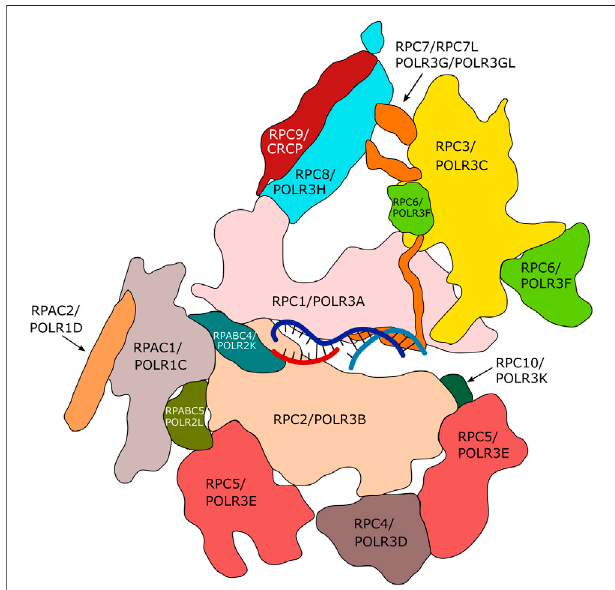
FIGURE 1 | Subunits of human RNA polymerase III. Fourteen of the seventeen subunits of human Pol III are appropriately assigned. Subunits POLR2E, POLR2F and POLR2H are not displayed. The Figure is inspired by the structure of human Pol III published by Girbig et al. (2021) (PDB7AE3). The RPC4/RPC5 hetero-dimeric complex is required by termination/reinitiation. The RPC3/RPC6/RPC7 hetero-trimeric subcomplex is required for transcription